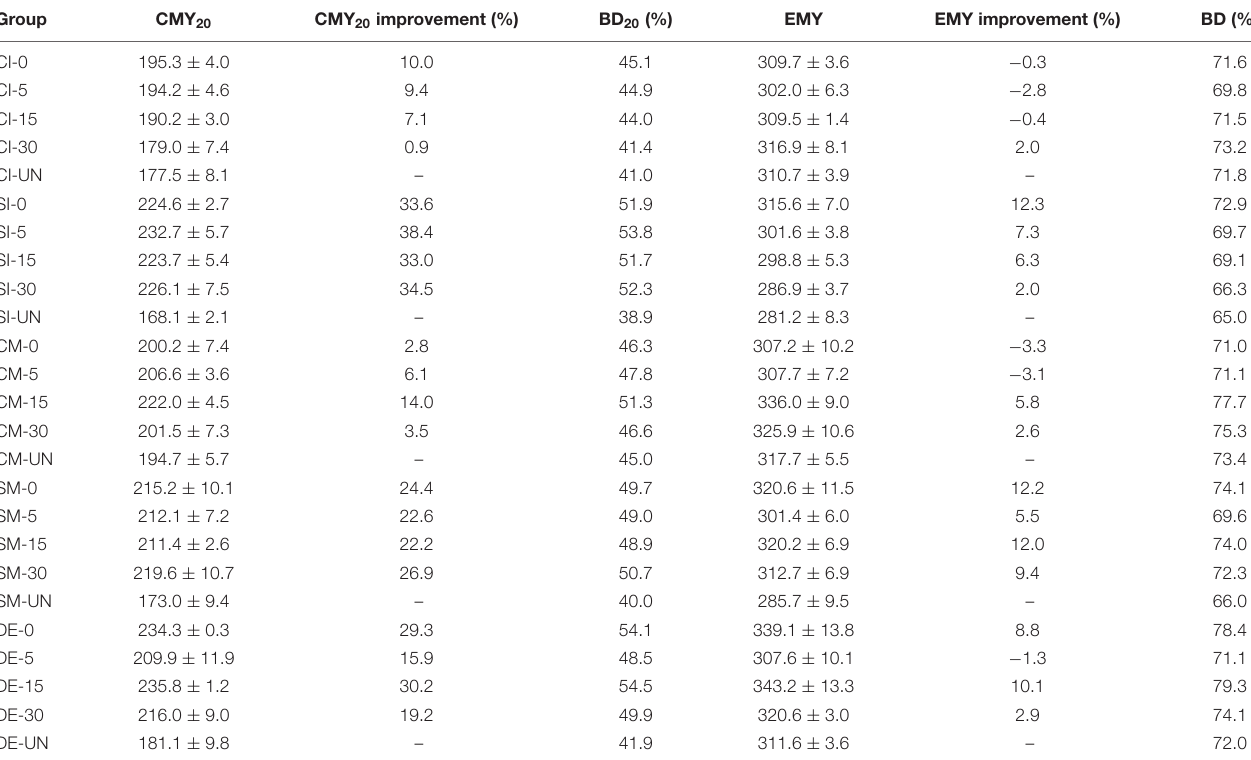
TABLE 2 | Digestion performance of untreated and pretreated PW.